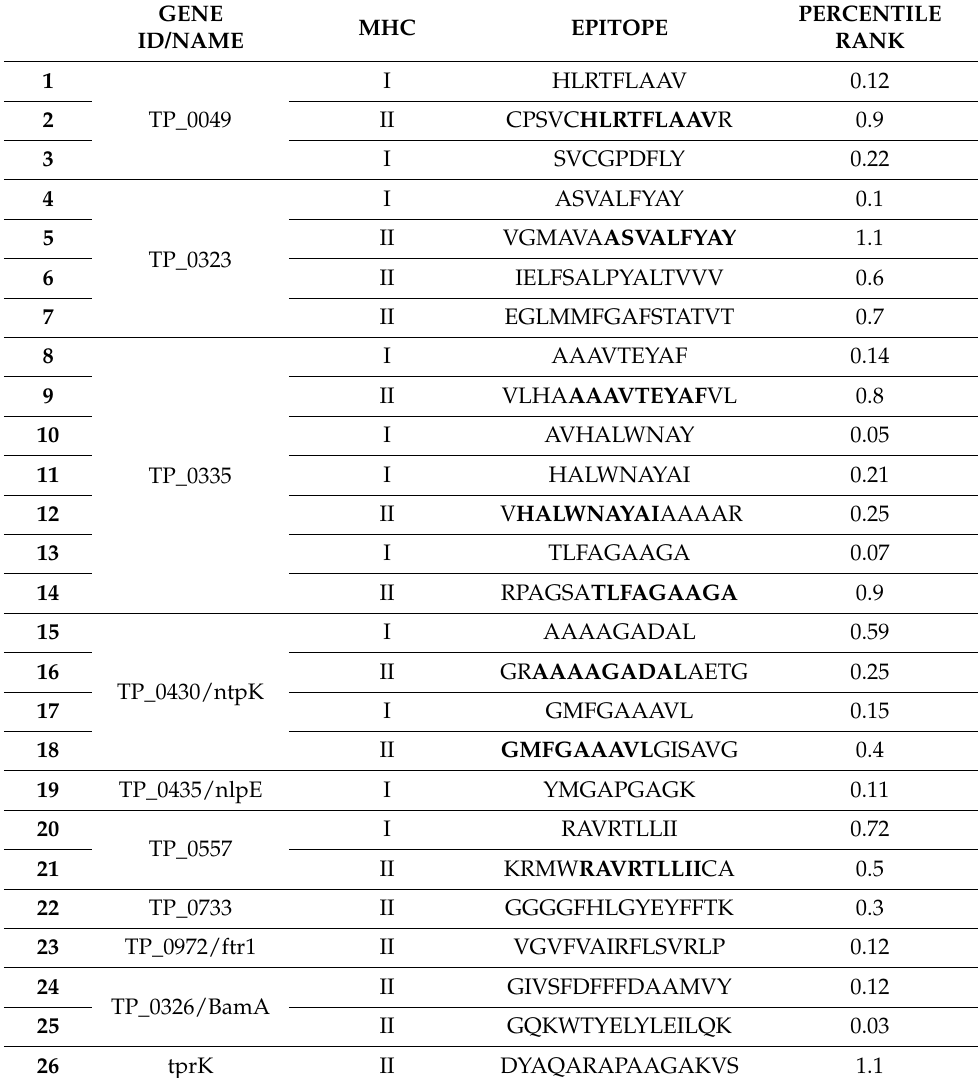
Table 1. Final epitopes selected for immunogen construct. Highlighted in bold is the overlap between MHC-I and MHC-II